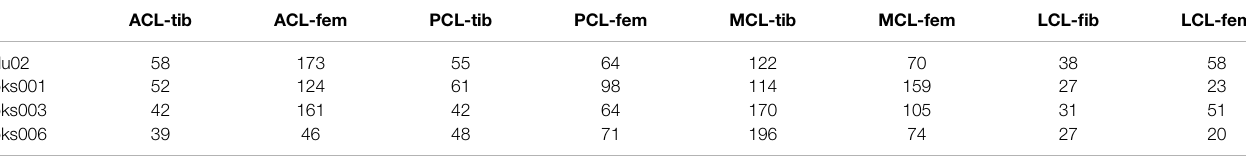
TABLE 4 | The number of nodes in the original ligament attachment rigid tied contact (Set 1) per model. The number of nodes in Set 2 is half the number of nodes in Set